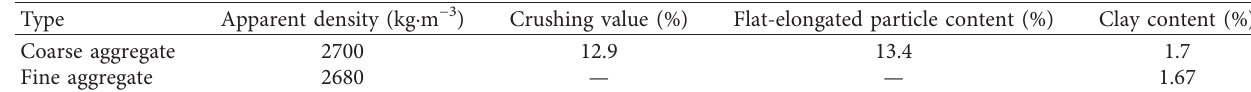
Table 3: Properties of aggregates.